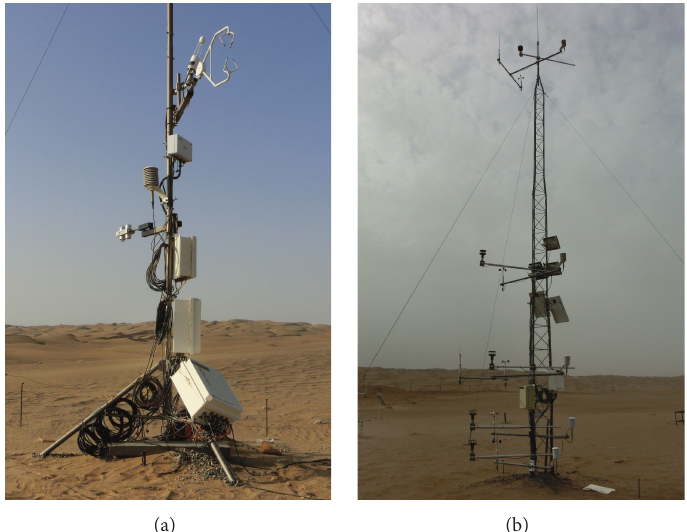
Figure 2: Eddy-covariance measurement system and radiation observation system on 3 m tower (a) as well as wind and temperature profiles measurement system on 10 m tower